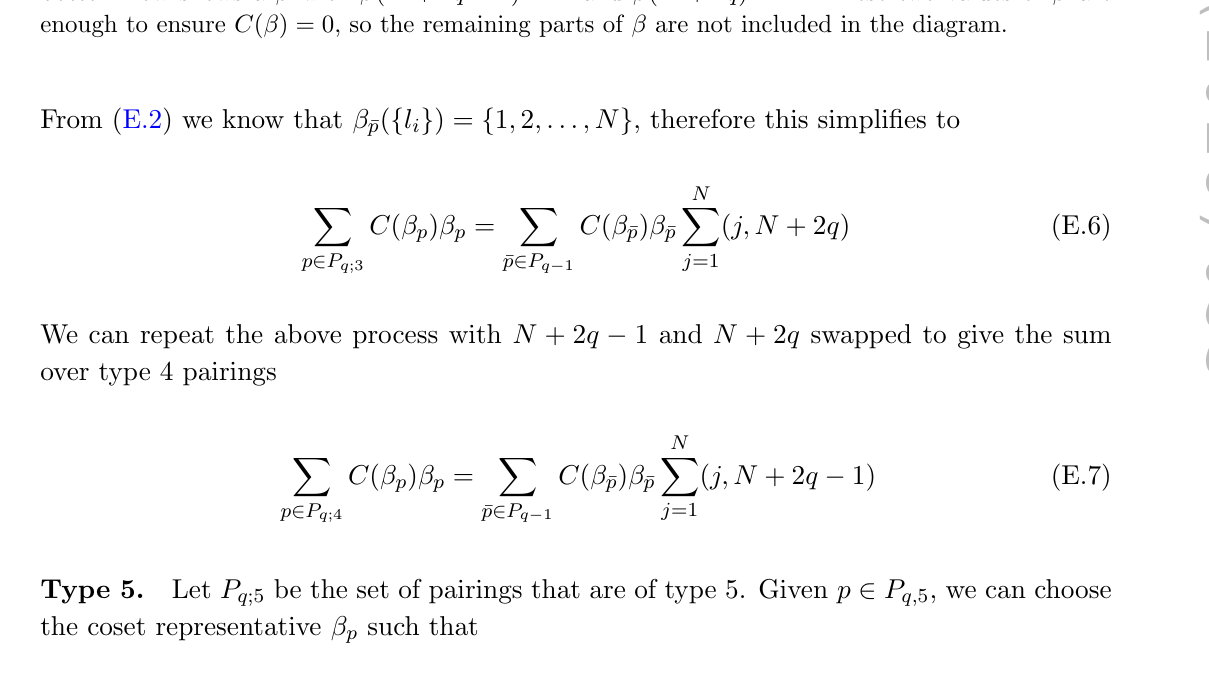
From (E.2) we know that (cid:12)